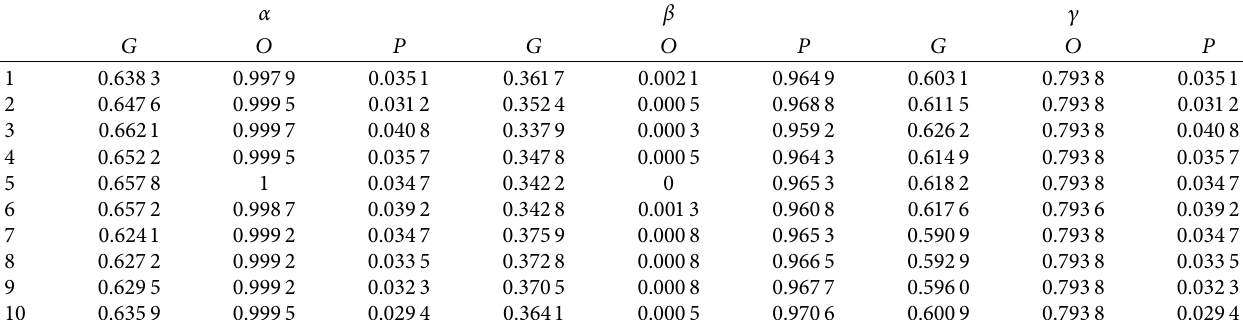
Table 8: Uncertainty measurement on “winequality-white.”